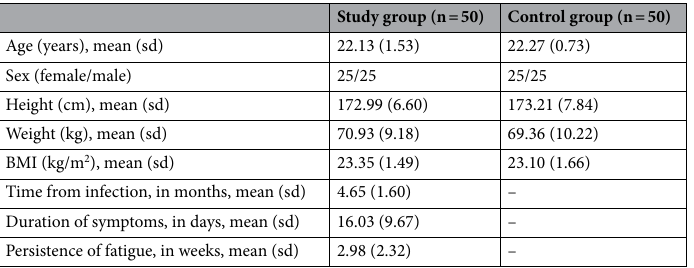
Table 1. Baseline characteristics of study and control groups. sd standard deviation, BMI body mass